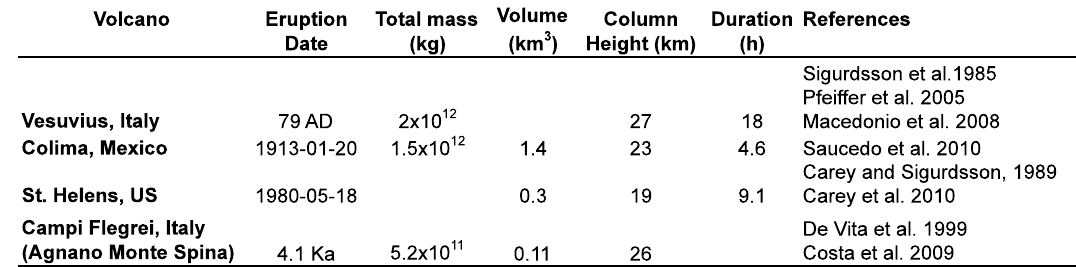
Table 3. Main parameters of the 1913 eruption as compared to other Plinian eruptions.